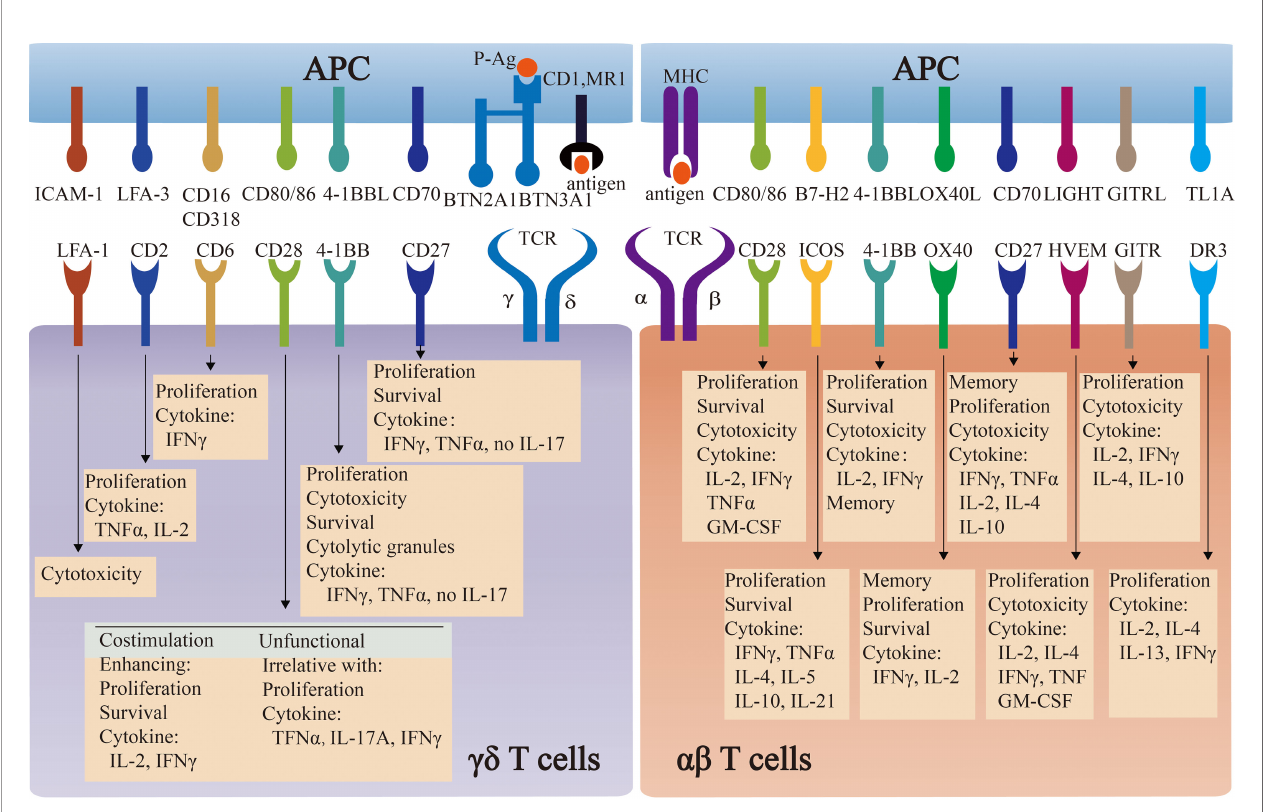
FIGURE 2 | The comparison of co-stimulatory molecules and their induced effector functions between ab T cells and gd T cells. Co-stimulatory molecules induce the effector functions of ab T cells and gd T cells, by engaging respective ligands and counter-receptors on APCs. The speci fi c functions of some molecules are commonly well-understood in ab T cells, whereas they are controversial in gd T